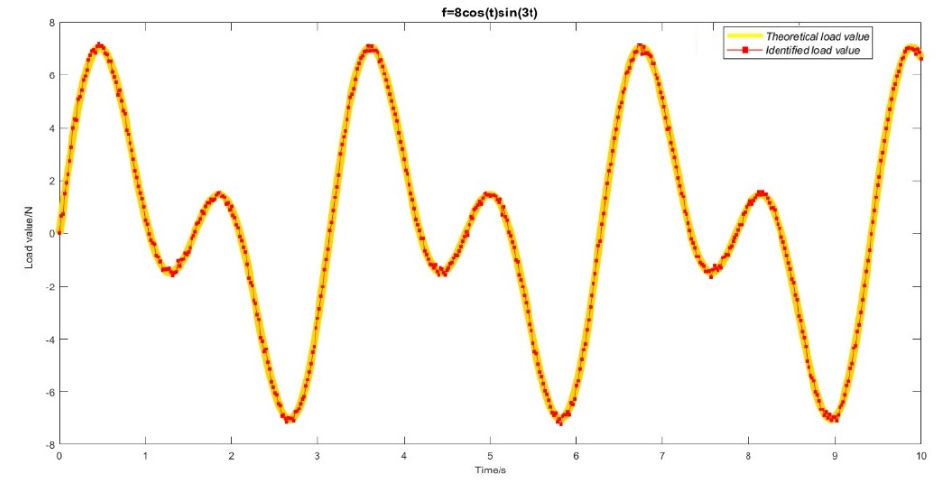
Figure 7. Multiple-degree-of-freedom system load-identification results.